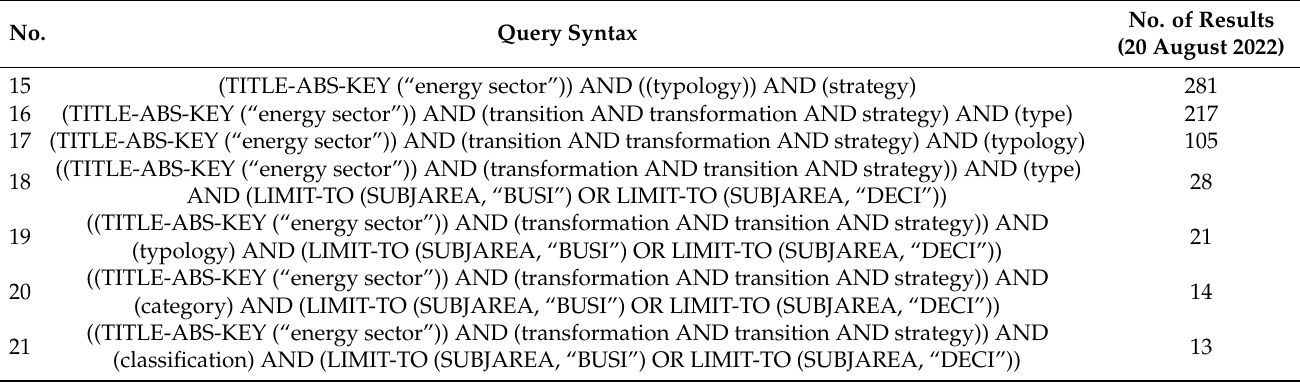
Table 2. Queries focused on typologies used in the Scopus scientific database